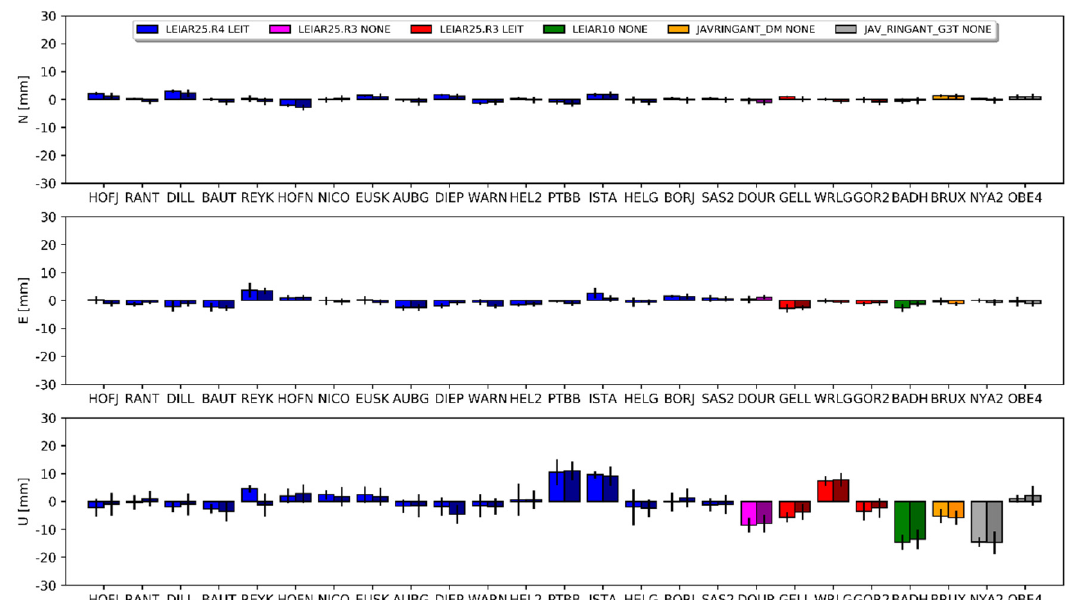
Figure 10. Coordinate differences between the G2 and G1 solutions and their standard deviations. Darker columns refer to the DD approach. Values are presented in Table A6.